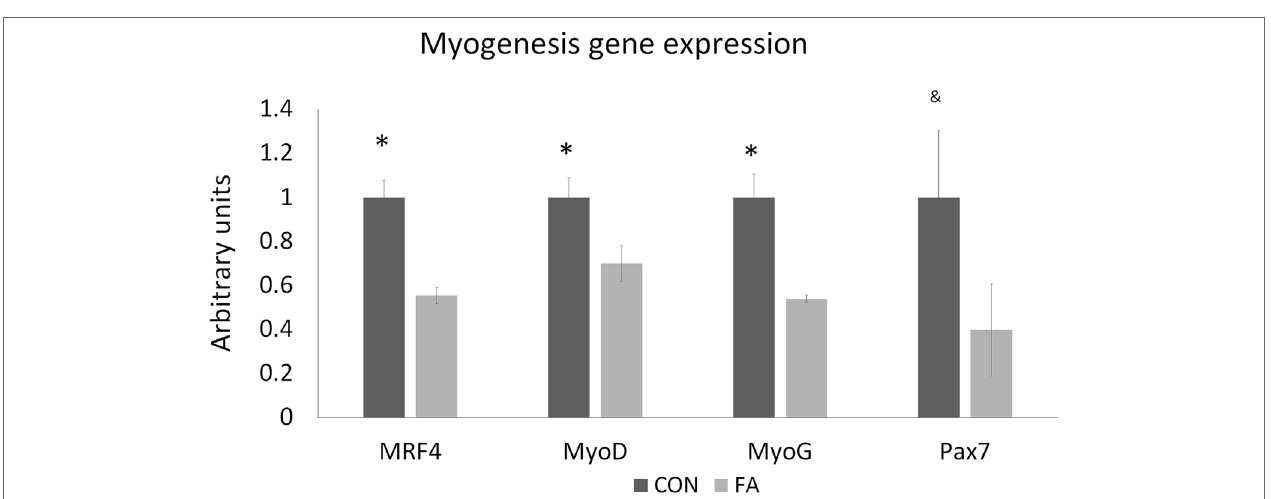
FigUre 1 | Myotube formation of C2C12 cells in control (CON) and EPA/DHA (FA) medium. (a–F) H&E staining of C2C12 cells. Pictures are shown in different magnification: 100 × and 200 × . (g) The diameter and length of myotubes measured based on the H&E staining images. Data show the change of the diameter and numbers of myotubes in FA group compared with CON group. The relative changes were calculated in arbitrary units. * P < 0.05; n = 9 pictures for each